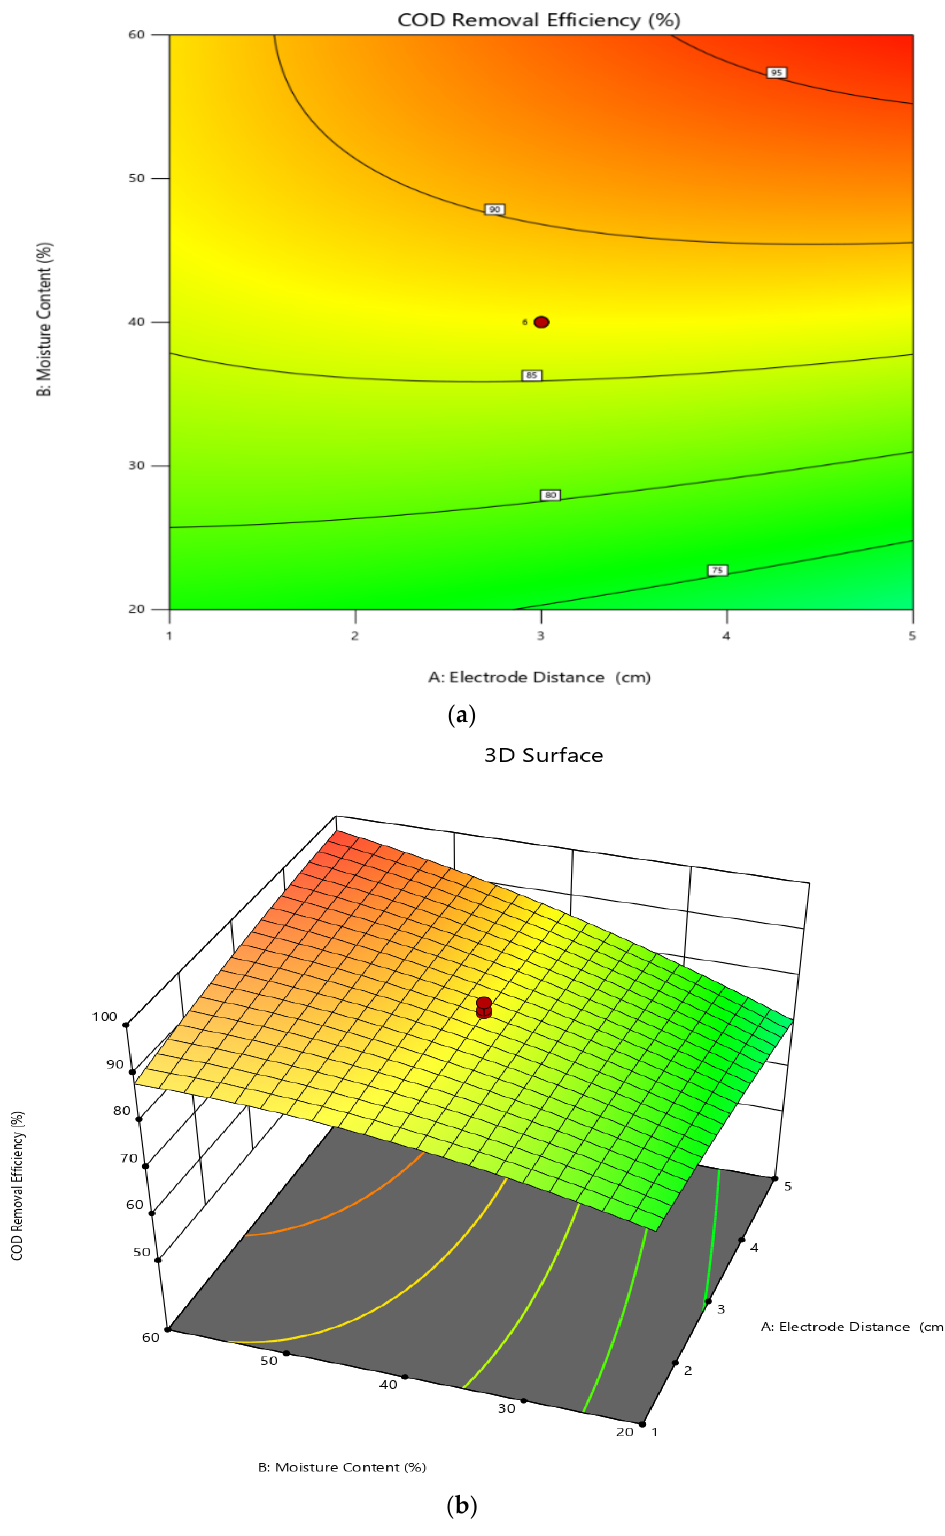
Figure 6. ( a ) Contour plot and ( b ) response surface plot of biomass as a function of moisture content relative to electrode